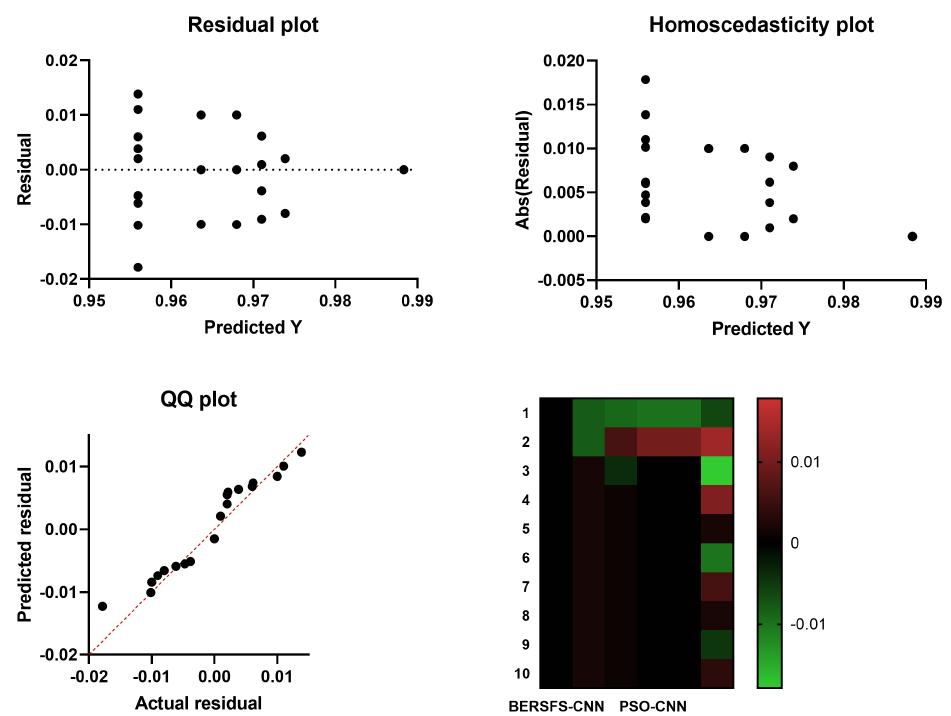
Figure 4. The homoscedasticity graphs, heat maps, residual plots, and QQ plots of the BERSFS-CNN and other optimization-based models. Table 12. Results of comparisons between proposed classifiers and those obtained from ANOVA.